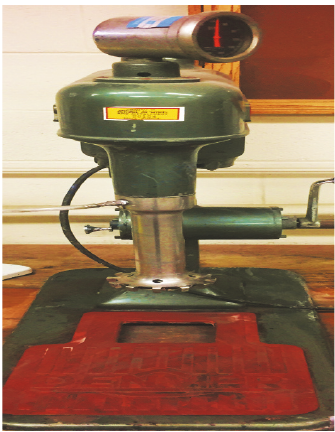
Figure 5: Denver flotation cell used in the current